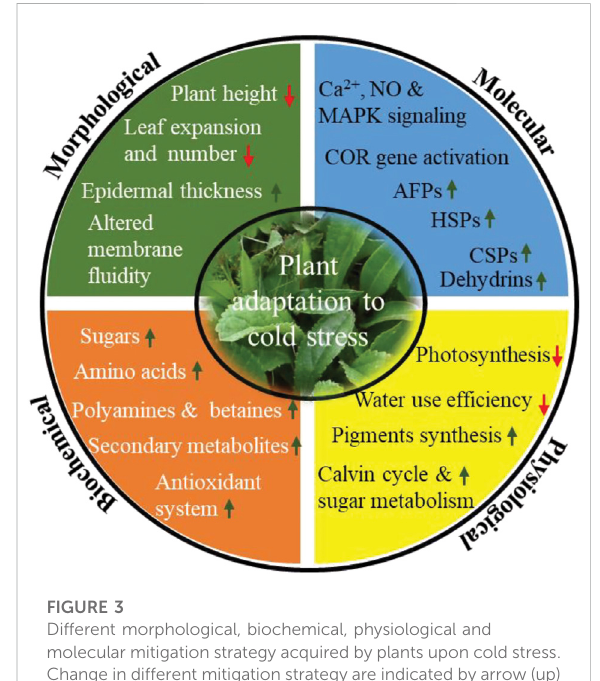
FIGURE 3 Different morphological, biochemical, physiological and molecular mitigation strategy acquired by plants upon cold stress. Change in different mitigation strategy are indicated by arrow (up) indicates increased concentration/expression, whereas arrow (down) indicates decreased